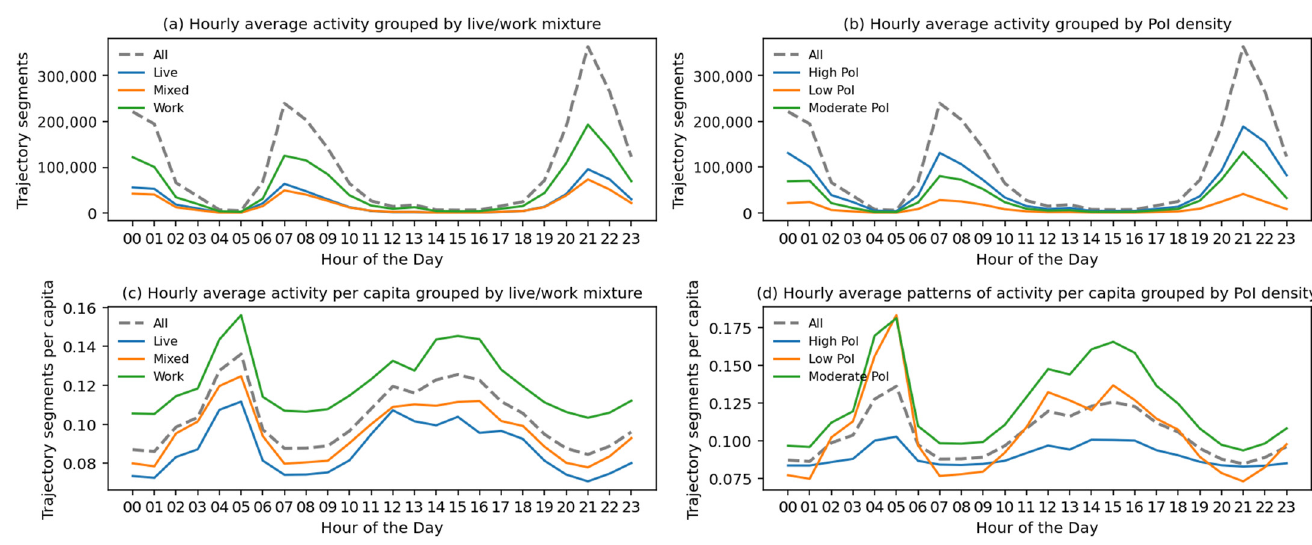
Figure 5. Time series of average hourly patterns of physical activity grouped by live/work mix and PoI density.